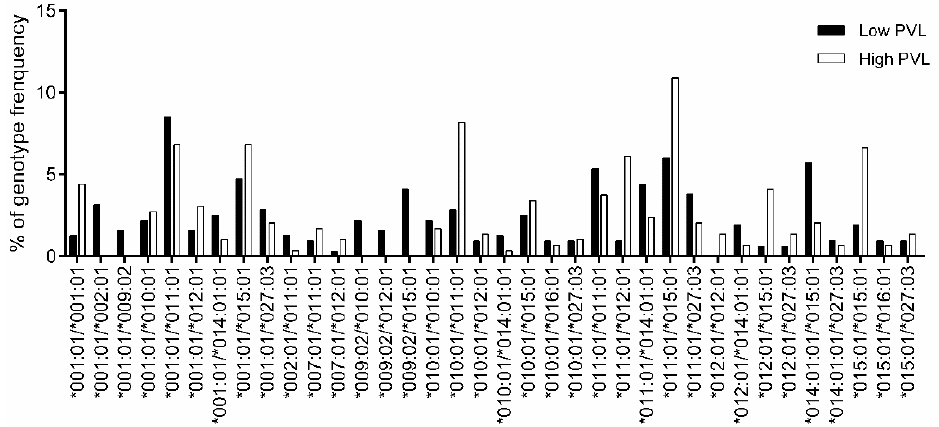
Figure 5. Comparison of BoLA-DRB3 genotype frequencies between HPVL and LPVL cows. The genotype frequencies of 317 LPVL ( ■ ) and 294 HPVL cows ( □ ) were calculated for each BoLA-DRB3 genotype (Table S9); a total of 36 out of 92 genotypes with frequencies > 1% are shown. The X-axis and Y-axis show the genotype name and frequency (%) for each BoLA- DRB3 genotype, respectively.